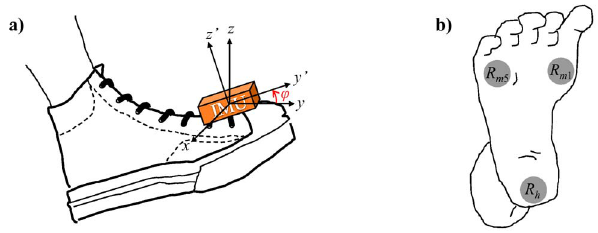
Figure 1. Schematic of positions for IMU and FSRs. a) An IMU is attached to the shoe and Q measures the angular position in the sagittal plane with respect to resting position and b) FSRs are placed on the sole of the foot at the heel and the first and fifth metatarsals. doi:10.1371/journal.pone.0073152.g001 PLOS ONE |